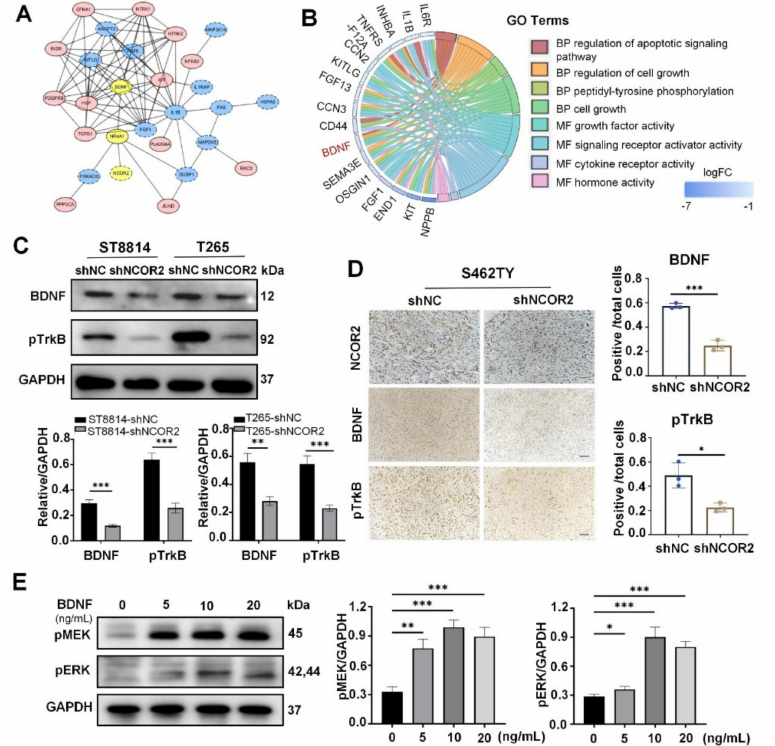
Figure 5. BDNF can regulate the MAPK signalling pathway in NF1-derived MPNST cells. ( A ) Protein– protein interaction network showing that BDNF occupied a central position among the altered genes in MAPK signalling pathway. ( B ) GO enrichment analyses showing BDNF plays a role in related cell growth and apoptosis processes. ( C , D ) WB and IHC showing BDNF and pTrkB protein levels were decreased in ST8814-shNCOR2 and T265-shNCOR2 cells. Scale bar, 50 µ m. Data are shown as mean ± S.D., n = 3; * p < 0.05, ** p < 0.005, *** p < 0.0005. ( E ) T265-shNCOR2 was treated with